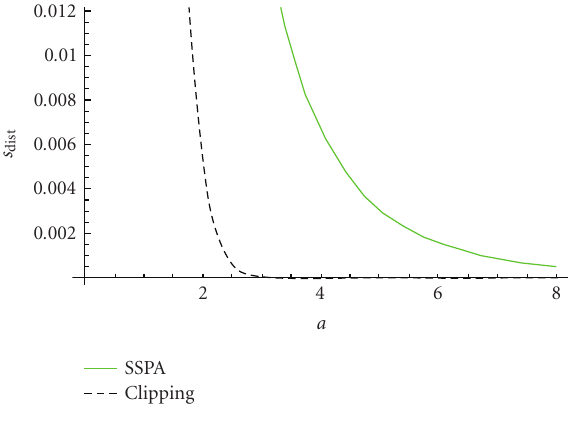
Figure 9: OFDM signal